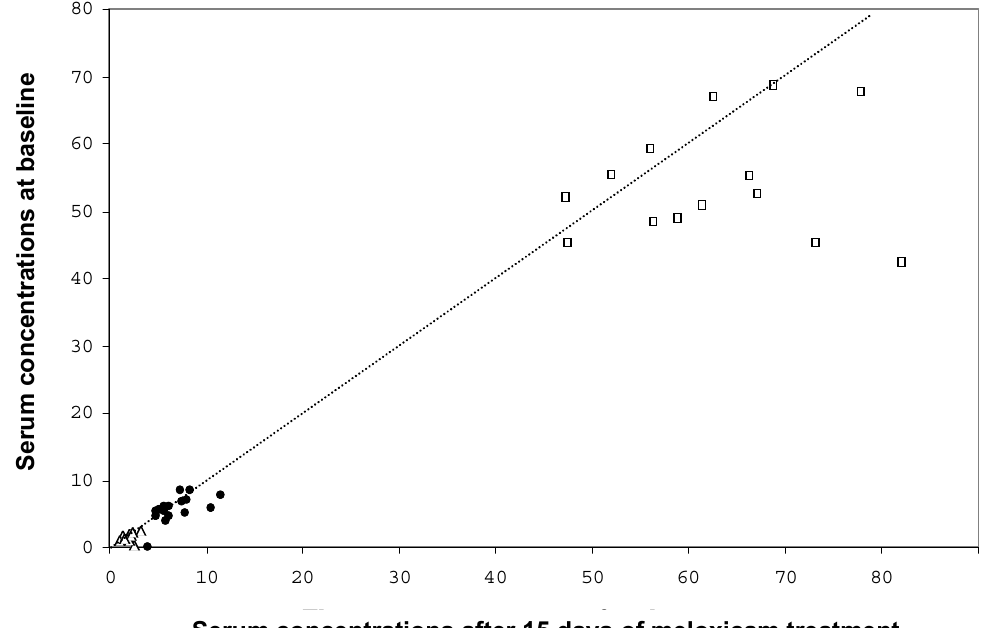
Figure 2. Effect of meloxicam on serum concentrations of neopterin (filled circles; nmol/L), tryptophan (open squares; µ mol/L) and kynurenine (triangles; µ mol/L), straight line indicates ideal regression line with no changes between measurements at baseline and during